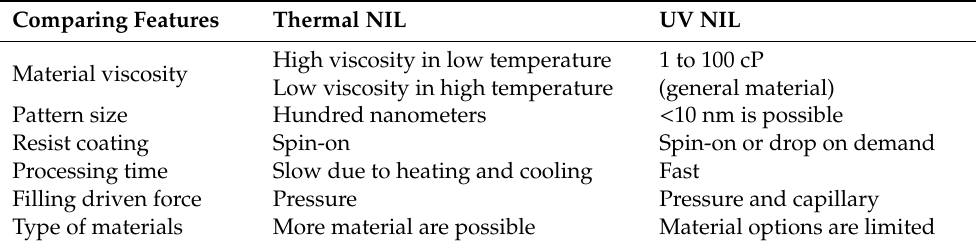
Table 1. Comparison of the thermal NIL and ultraviolet (UV) NIL.